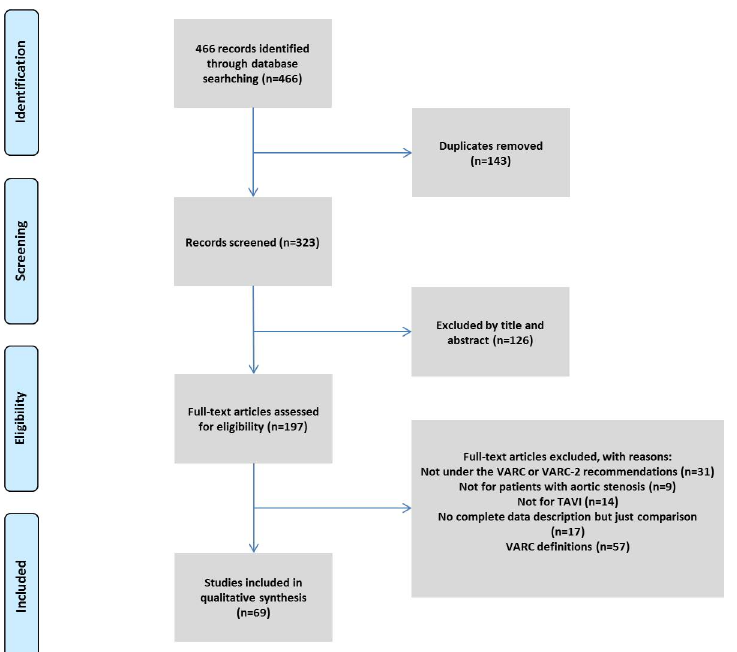
Fig 1. PRISMA Flow diagram of study